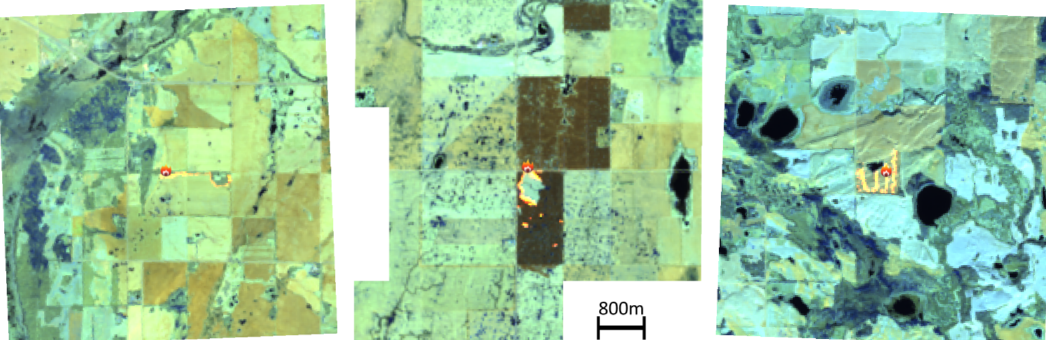
Figure 3. Examples of processed Landsat 8 images indicating fire detections considered agriculture burns. Note the regular geometric patterns of the fires, specifically the line ignition patterns and the burning of specific fields. The presence of previously burned fields is shown north of the active fire in the centre panel, which is registered in this study as low NDVI and very high rates of curing.